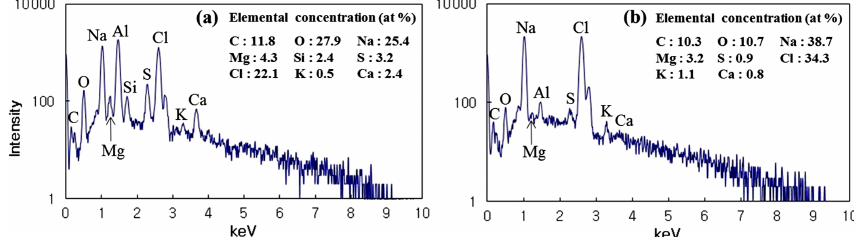
Figure 3. X-ray spectra and elemental atomic concentrations (in atomic %) of (a) the summertime and (b) wintertime SSA particles shown in Fig.